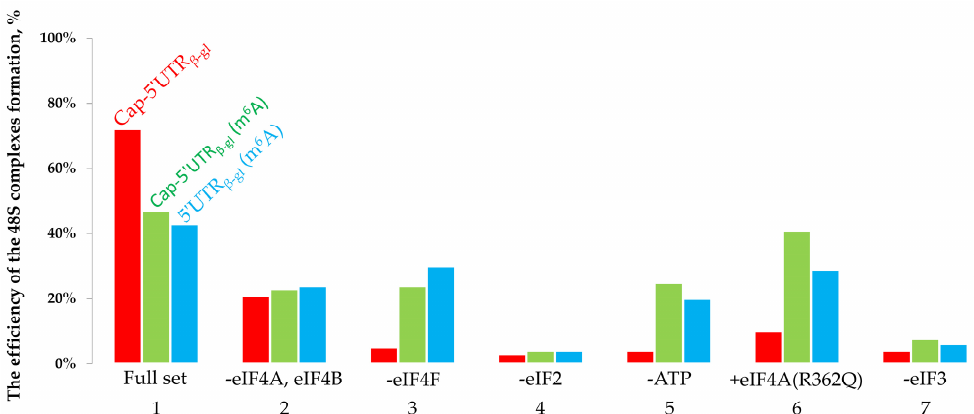
Figure 3. The efficiency of the formation of 48S complexes on mRNAs with the beta-globin leader. Red column, capped unmodified mRNA (Cap-5 ′ UTR b-gl ); green column, capped m 6 A-modified mRNA (Cap-5 ′ UTR b-gl (m 6 A)); blue column, uncapped m 6 A-modified mRNA (5 ′ UTR b-gl (m 6 A)). The histogram is based on the specific fluorescence intensities corresponding to 48S peaks of the toe- printing reaction (Figure 2). Y-axis, fluorescence percentage at the AUG codon.